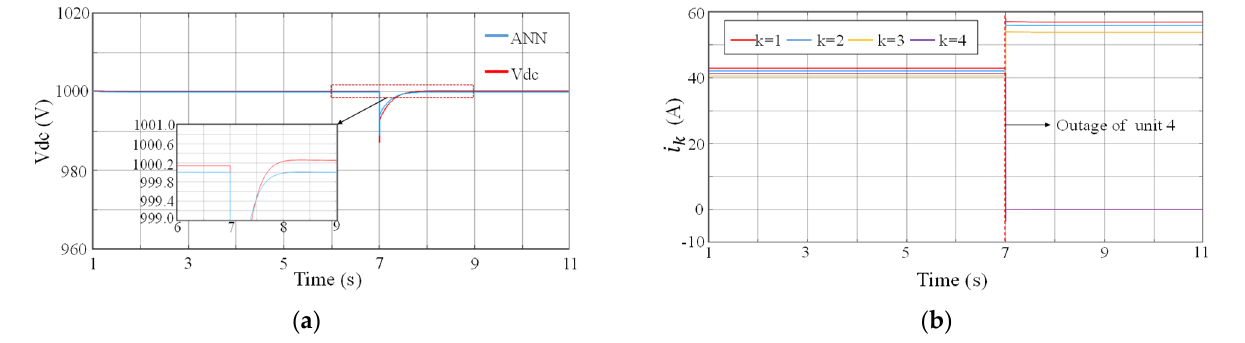
Figure 7. ( a ) Values of DC bus voltage and ANN output in case study 3; ( b ) Values of currents of the bidirectional DC ‐ DC converters in case study 3.